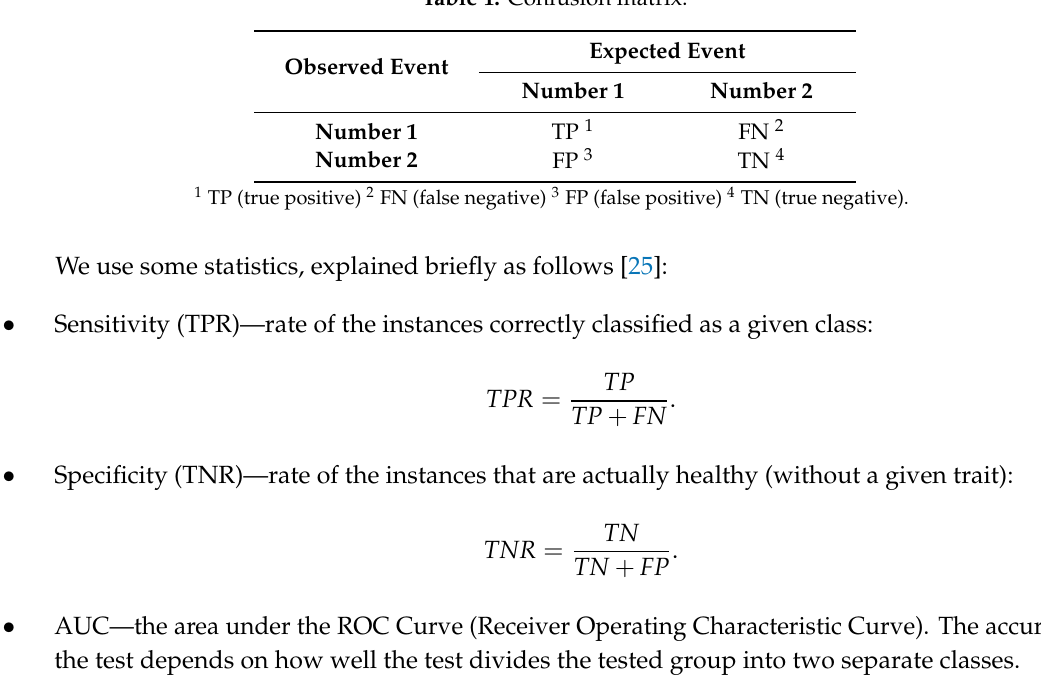
Table 1. Confusion